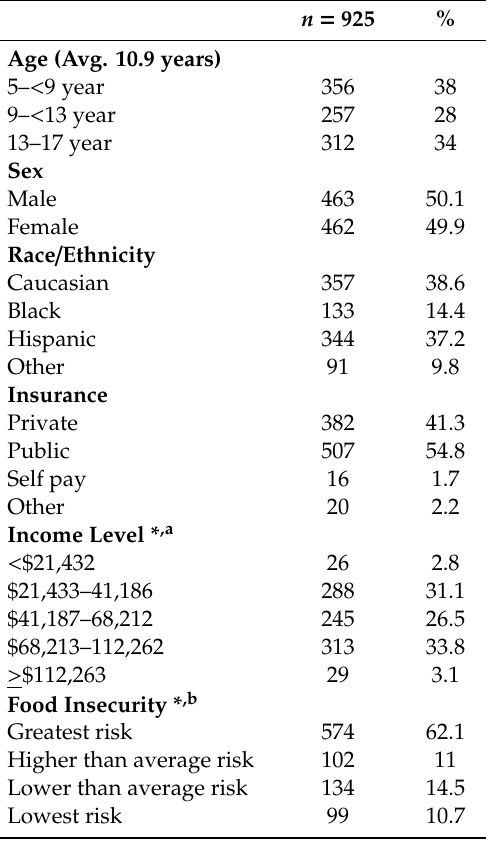
Table 1. Characteristics of children seeking medical care in a Pediatric Emergency